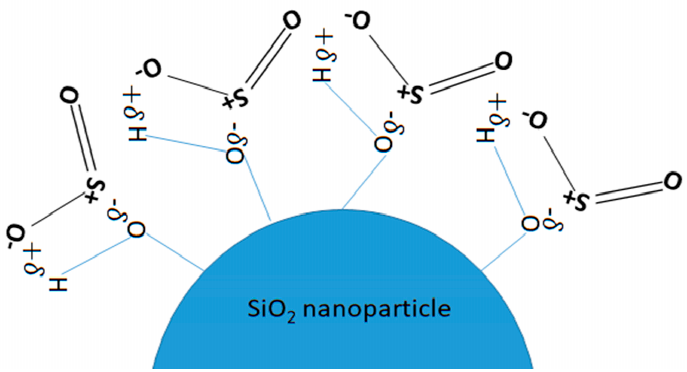
Figure 11. Schematic diagram of grazing effect of SiO 2 nanoparticles during the absorption of SO 2